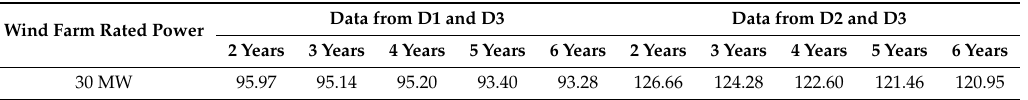
Figure 5. Alstom ECO 80/2000 Class II power output in kW varying to wind speed and air density. Table 7. E , in GWh / year, for each resulting MCP-synthesized time series, considering the vertically extrapolated data from 42 to 81 m and varying the length of each time series.